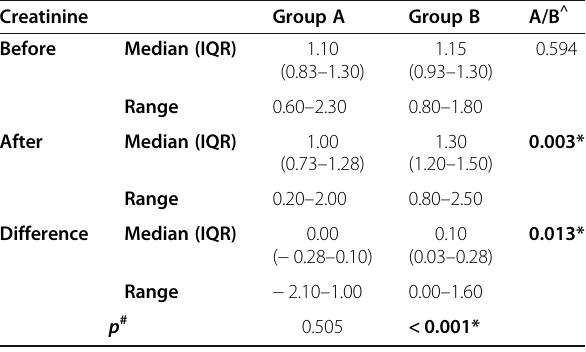
Table 9 Comparison between study groups as regards ICU